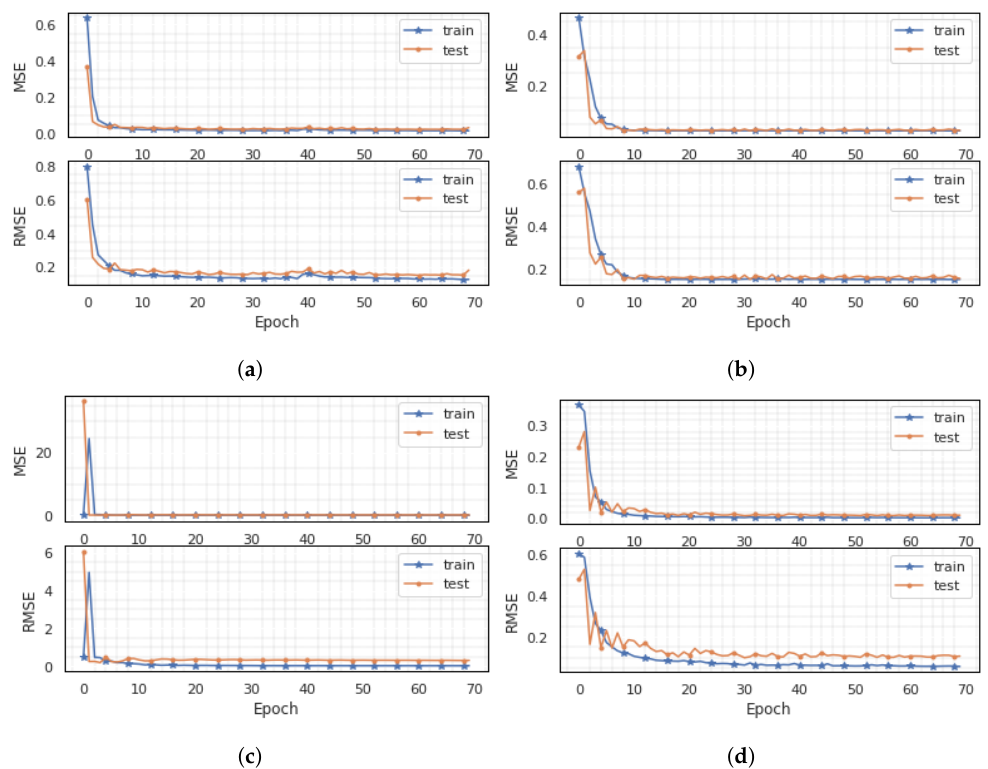
Figure 6. Training and validation loss during training for different daily datasets for generalisation performance. ( a ) Hospital; ( b ) Office; ( c ) Restaurant; ( d )